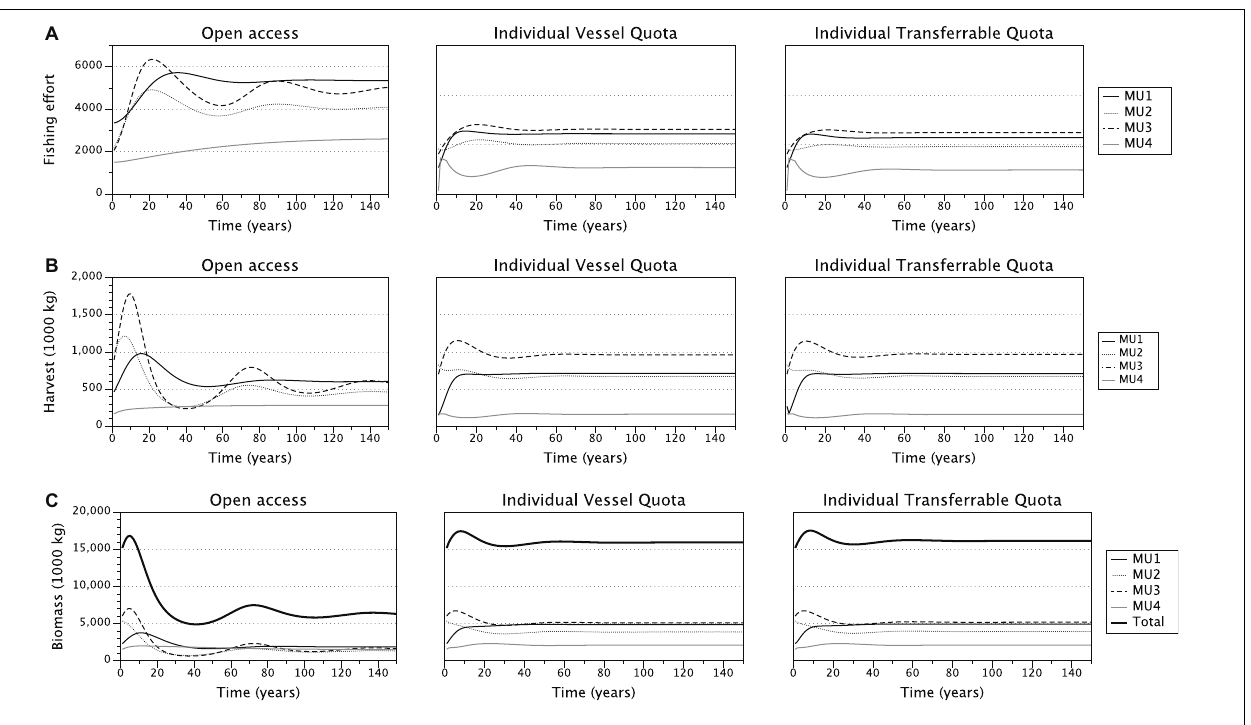
FIGURE 2 | Time paths of effort (panel A ), Yellow Perch harvested biomass (panel B ), Yellow Perch stock size (panel C ) under open access, IVQ and ITQ management scenarios.